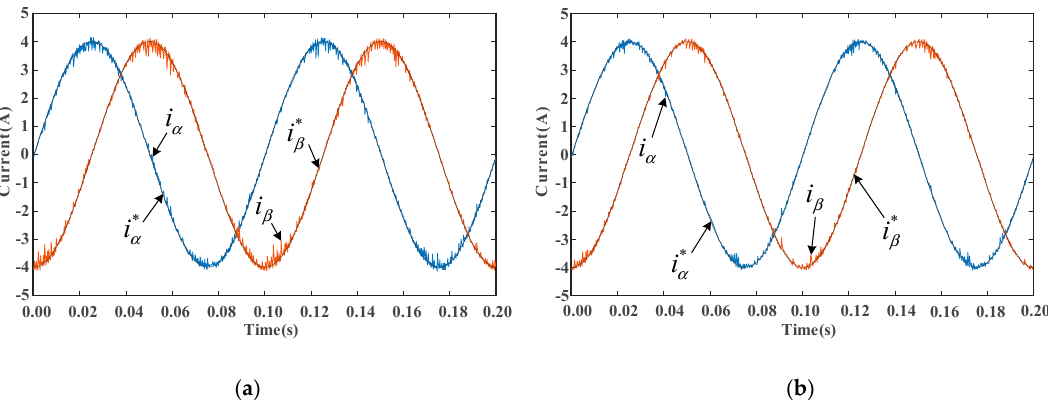
Figure 9. Trajectories of steady-state current under command 4 A at 10 Hz: ( a ) MPCC without modulation; ( b ) the proposed MMPCC.